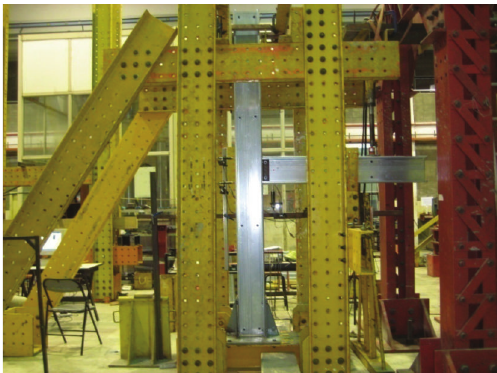
Figure 2: Isolated joint test setup for beam-to-column connection